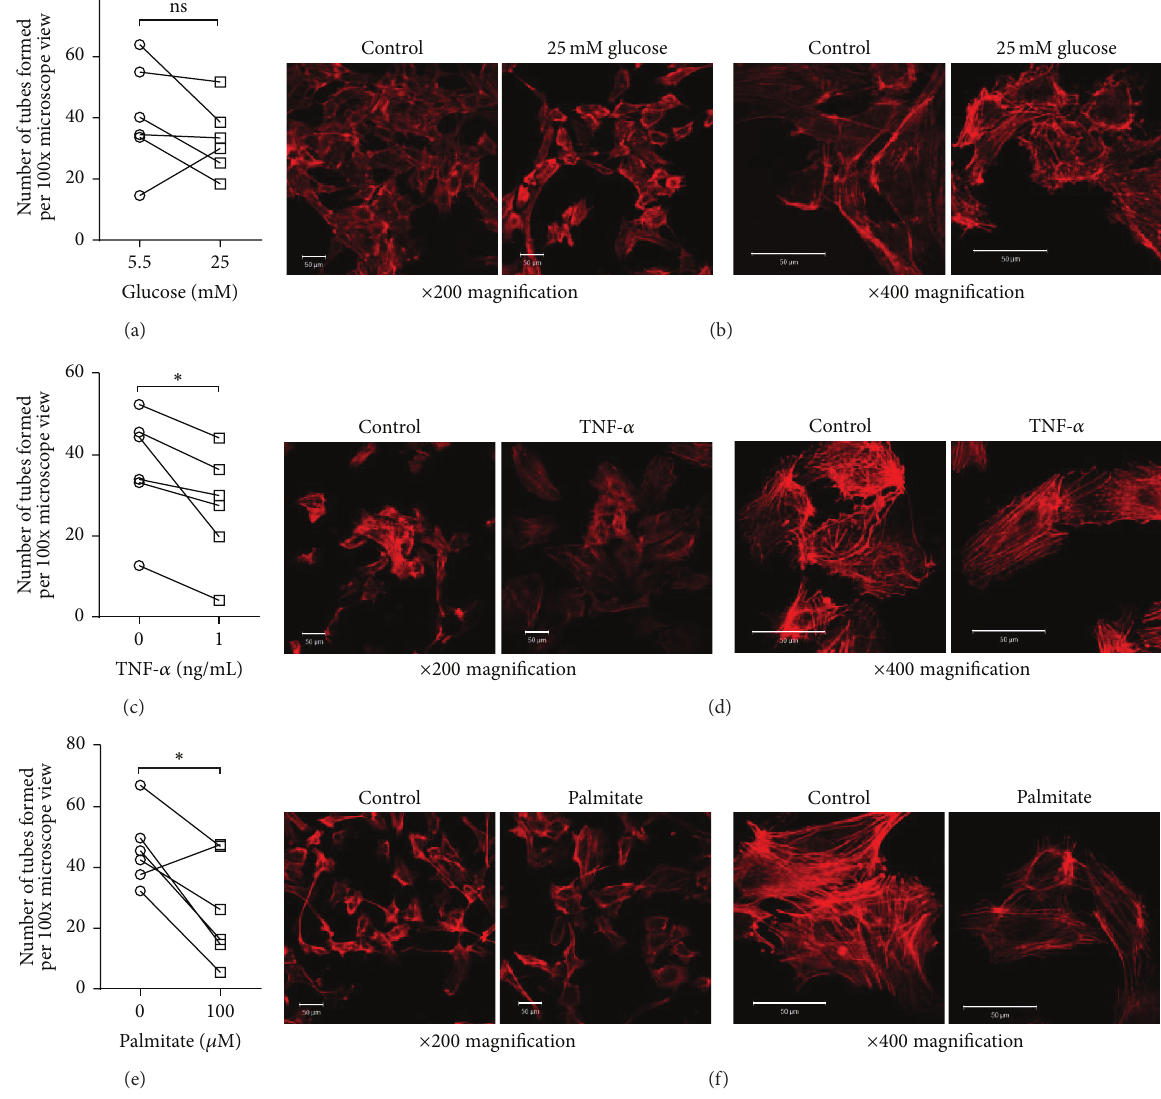
Figure 5: Effect of “diabetic” stimuli on SV-EC function. (a) ND-EC were treated with 25 mM glucose (with mannitol as osmolarity control) for 24 h before performing angiogenesis assays and counting the number of intact tubes ( 𝑛 = 5 ). (b) Similarly treated cells were fixed and the F-actin cytoskeleton visualised using rhodamine phalloidin. Scale bars = 50 𝜇 m. (c) Parallel assays were performed on cells treated with 1ng/mL TNF- 𝛼 as an inflammatory stimulus ((c, d), 𝑛 = 6 , ∗ 𝑃 < 0.05 ) and 100 𝜇 M palmitate to mimic an elevation in free fatty acids ((e, f), 𝑛 = 6 , ∗ 𝑃 < 0.05